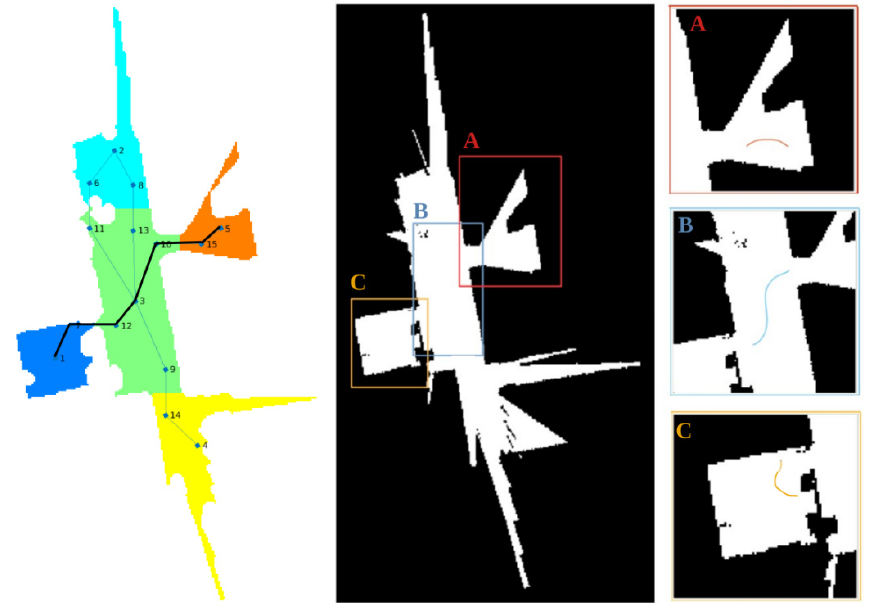
Figure 22. Complex scenario in which the robot needs to navigate through multiple rooms. The topological path is first computed ( left , where nodes are numbered in order of appearance) and the geometric path planner is applied locally to each of the rooms ( right , where rooms are labeled from start to end locations).